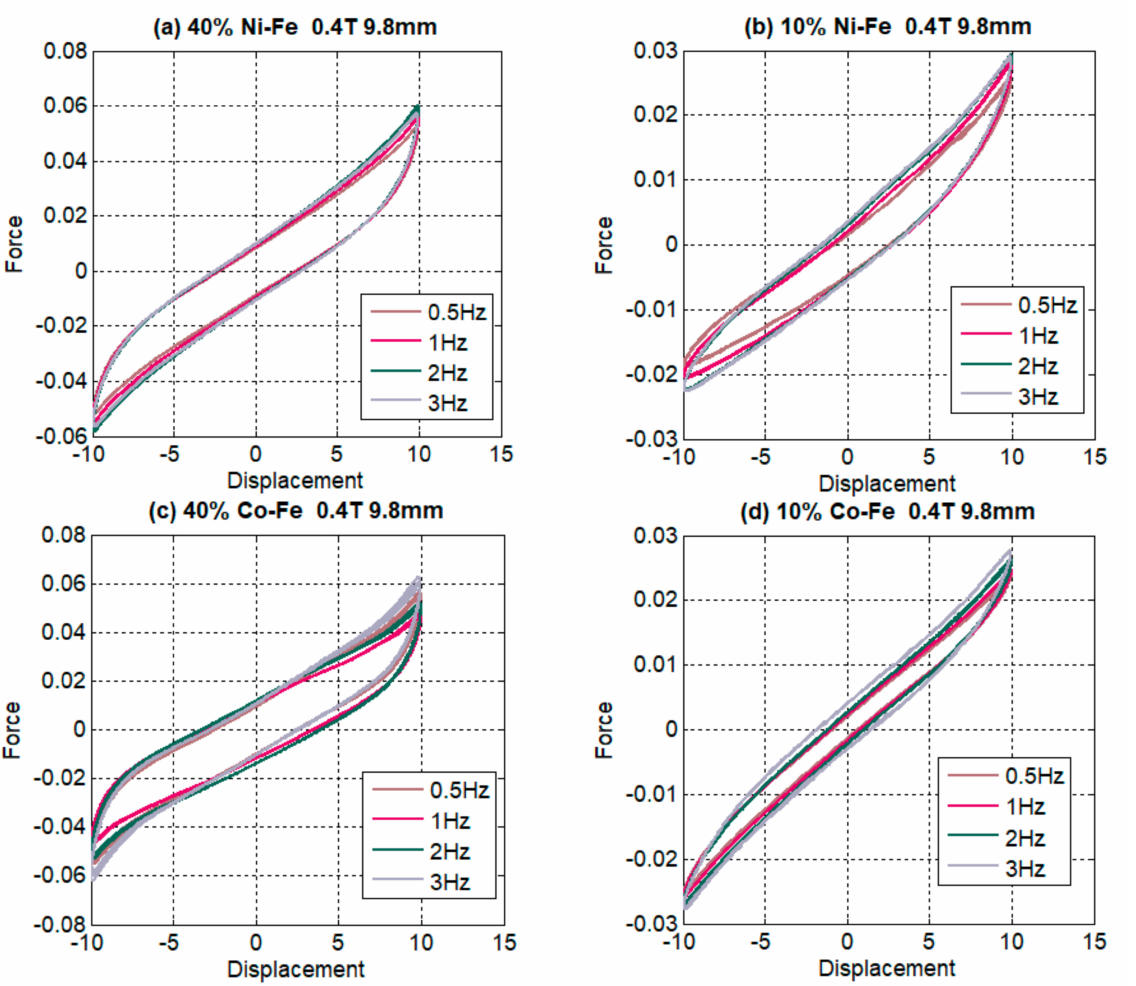
Figure 9. Comparison of force-displacement graphs for changing the frequency at maximum and minimum filler content for Ni-Fe MRE in ( a , b ) and Co-Fe MRE in ( c , d